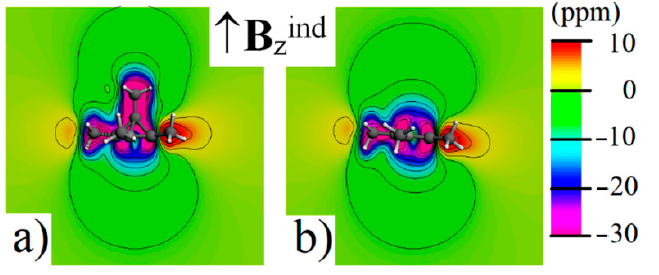
Figure 5. Contour plot representation of the B z ind terms for the induced magnetic field for C 6 (CH 3 ) 6 2+ ( a ) and C 5 (CH 3 ) 5 – ( b